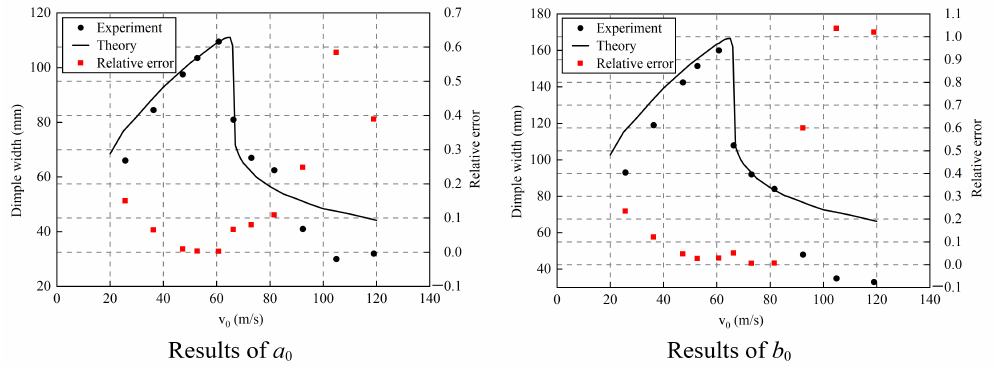
Figure 11. Validation of theoretical model via comparison with the experimental